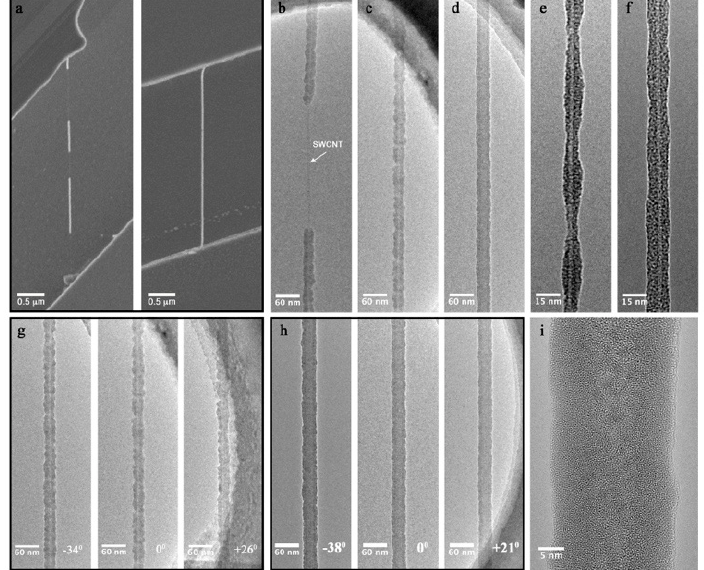
Figure 1. Morphology and coverage of CNT dielectric coatings. ( a ) SEM images of CNTs without TiO 2 pretreatment (left) and with TiO 2 pretreatment (right); ( b – i ) TEM images of CNTs with ( b ) 10 nm of Al 2 O 3 only; ( c ) 3 nm of Ti converted to TiO 2 and covered with 10 nm of Al 2 O 3 ; ( d ) 5 nm of Ti converted to TiO 2 and covered with 10 nm of Al 2 O 3 ; ( e ) 3 nm Ti converted to TiO 2 only; ( f ) 5 nm Ti converted to TiO 2 only; ( g ) 3 nm of Ti converted to TiO 2 with 10 nm of Al 2 O 3 , rotated over 60 ◦ along the nanotube axis; ( h ) 5 nm Ti converted to TiO 2 with 10 nm of Al 2 O 3 , three di ff erent projections of the CNT